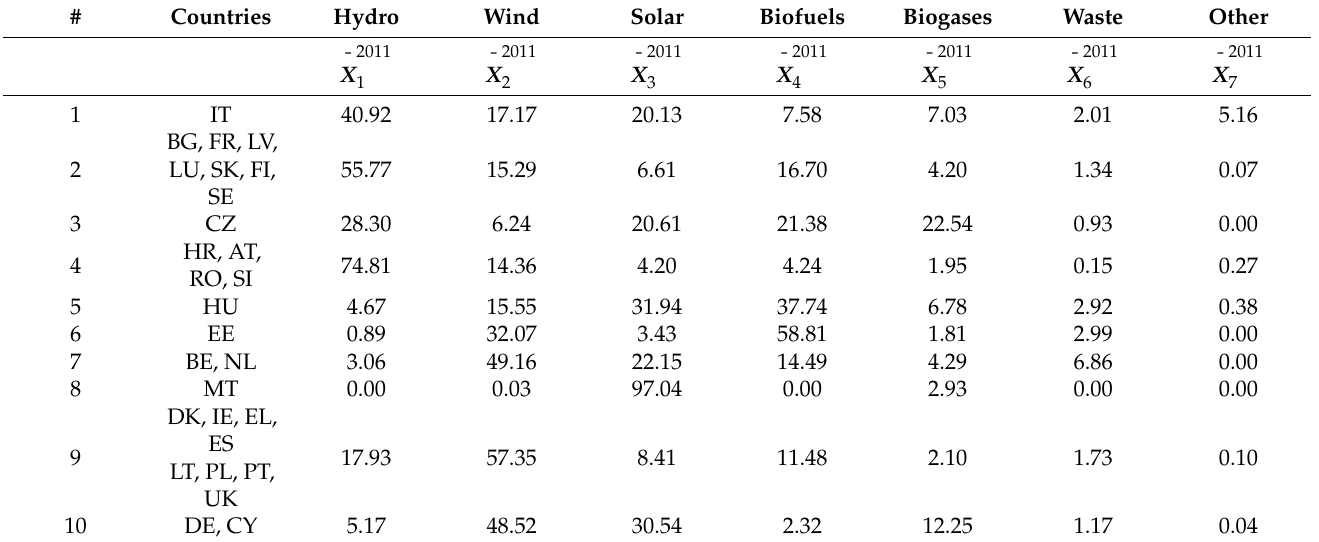
Table 7. Results of the classification of EU countries according to the shares of individual renewable energy sources in the production of electricity (clusters averages, %)—data from 2019. Countries Hydro Wind Solar Biofuels Biogases Waste